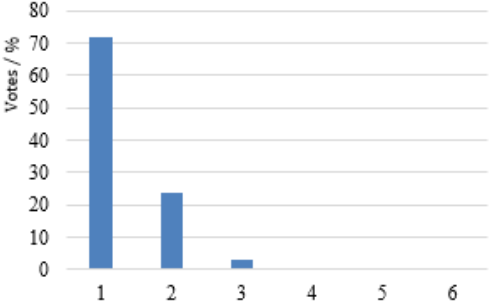
Fig. 8. Result of query (single choice, N = 58): “The benefit in using VR for my understanding of the derivation of a stream filament of Bernoulli” in school marks (1 = very good, 6 = very